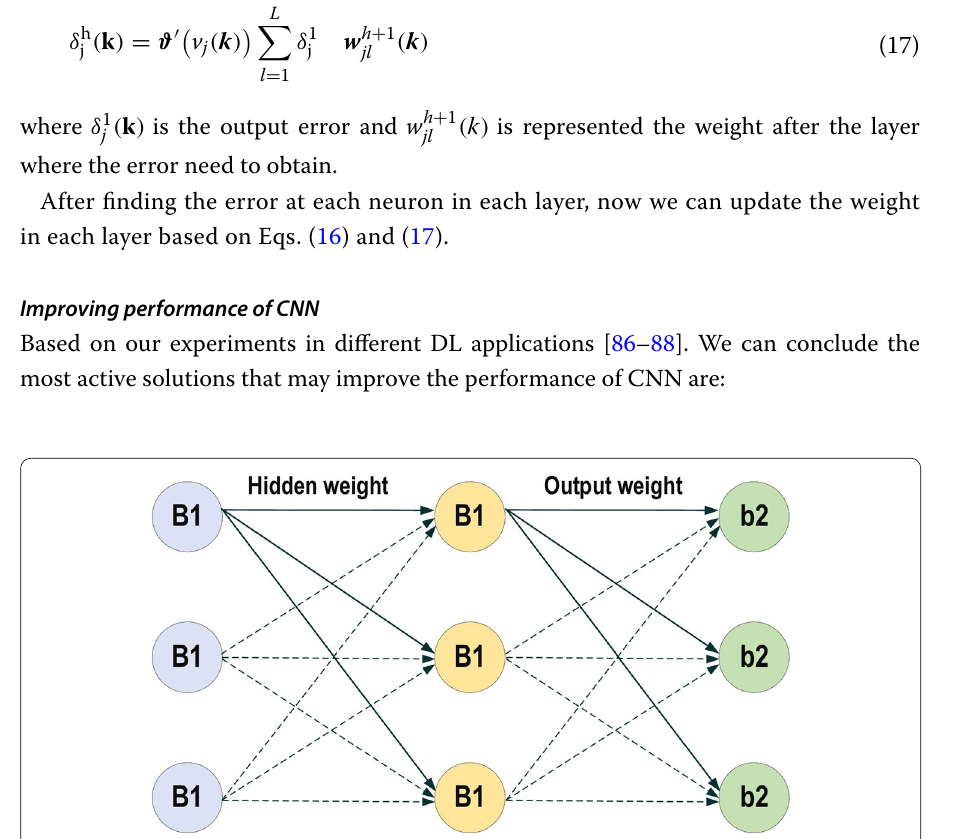
Fig. 13 Neuron activation